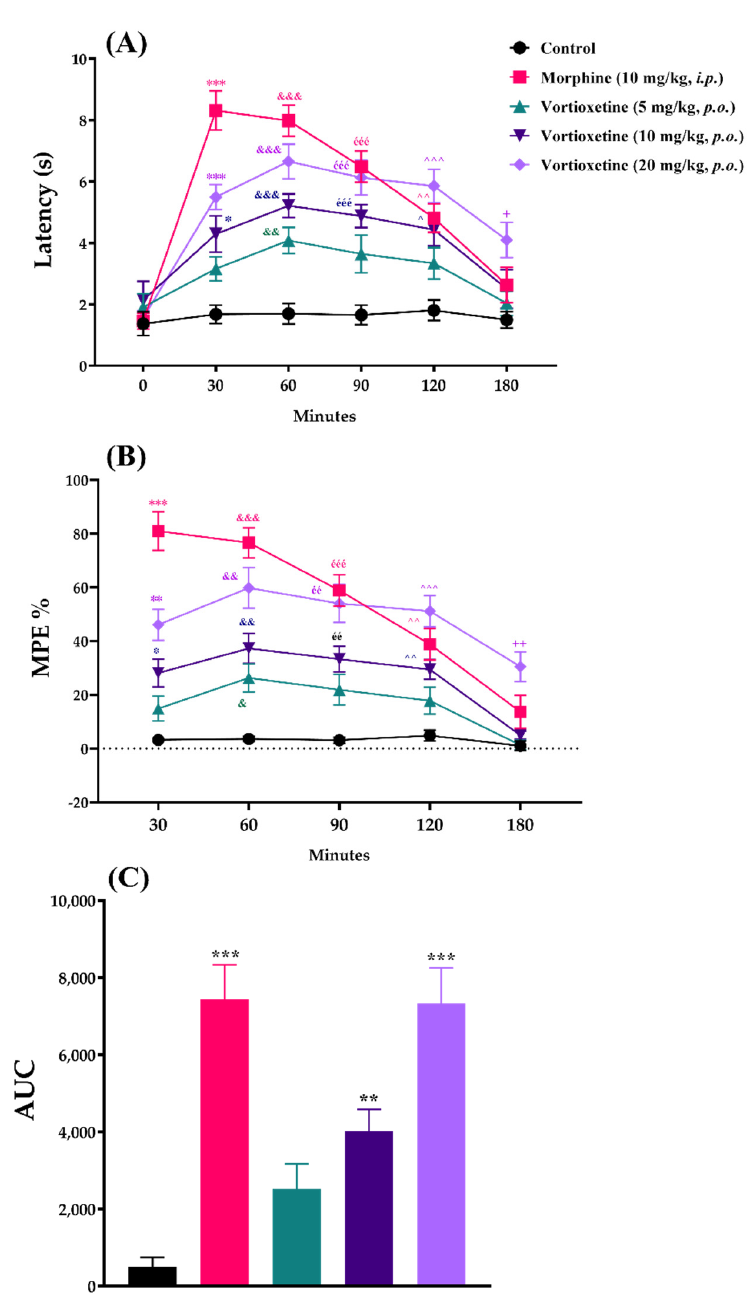
Figure 2. The effects of morphine (10 mg/kg, i.p. ) and vortioxetine (5, 10 and 20 mg/kg, p.o. ) administrations on latency ( A ), MPE% ( B ) and AUC ( C ) values of mice in the tail-clip test (mechanical nociception). ( A ) and ( B ): Significant difference against control group at 30th min * p < 0.05, ** p < 0.01, *** p < 0.001; at 60th min & p < 0.05, && p < 0.01, &&& p < 0.001; at 90th min éé p < 0.01, ééé p < 0.001; at 120th min ^ p < 0.05, ^^ p < 0.01, ^^^ p < 0.001; at 180th min + p < 0.05; ++ p < 0.01. Two-way repeated ANOVA, post-hoc Tukey test, n = 7. ( C ): Significant difference against control group ** p < 0.01, *** p < 0.001; One-way ANOVA, post-hoc Tukey test, n = 7.